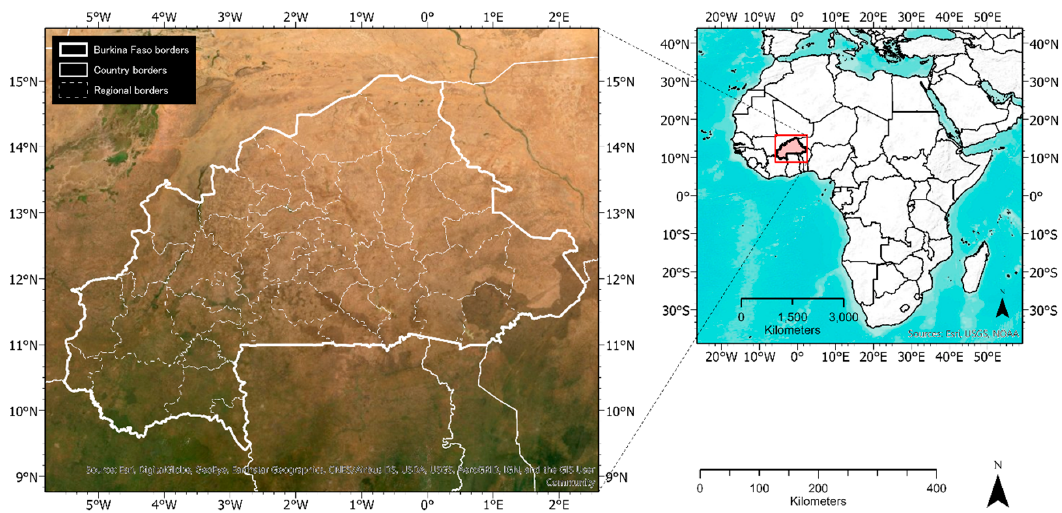
Figure 1. Reference map of study area: Burkina Faso.